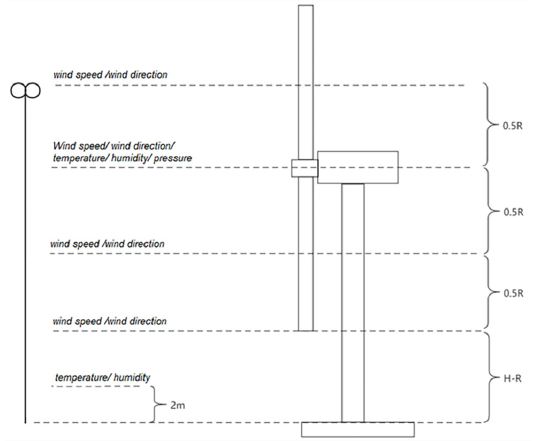
Figure 8. Effective measurement sector of the met mast.